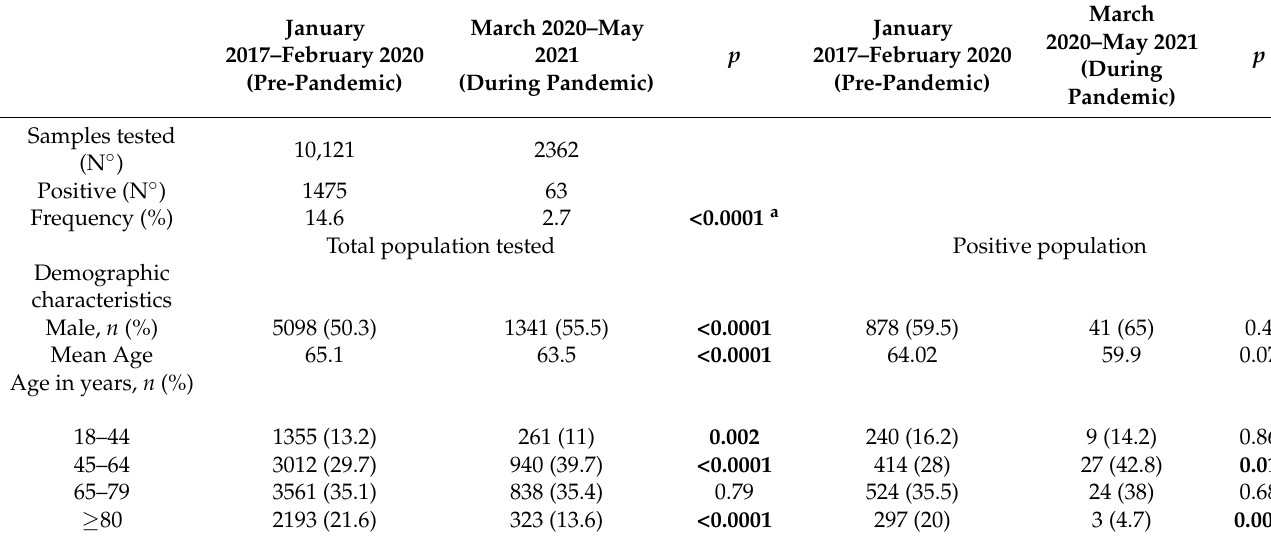
Table 1. Characteristics of patients tested for respiratory viruses other than SARS-CoV-2 during the study period (January 2017–May